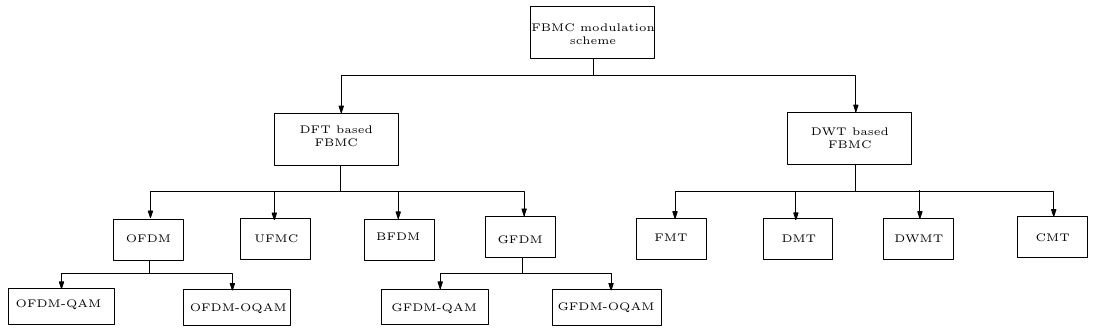
Figure 6. Classification of FBMC schemes based on